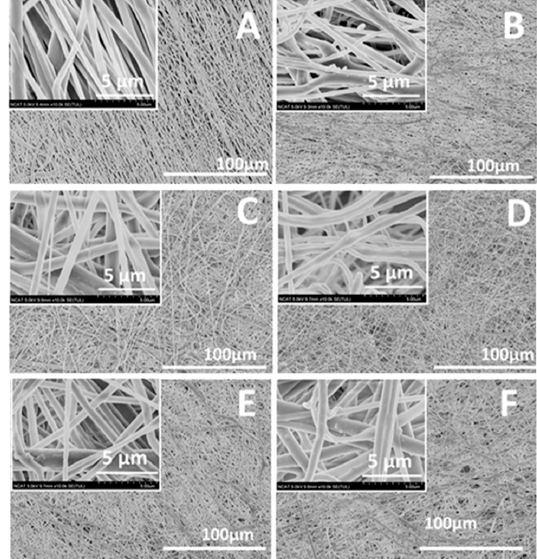
Figure 3. Scanning electron microscopy (SEM) images of magnetic polycaprolactone (PCL)/Aloe vera nanofibers containing ( A ) 0%; (B) 5%; ( C ) 10%; ( D ) 15%; ( E ) 20%; and ( F ) 25% Mg-ferrite nanoparticles. Insets show a higher magnification of each corresponding micrograph. nanofibers containing ( A ) 0%; ( B ) 5%; ( C ) 10%; ( D ) 15%; ( E ) 20%; and ( F ) 25% Mg-ferrite